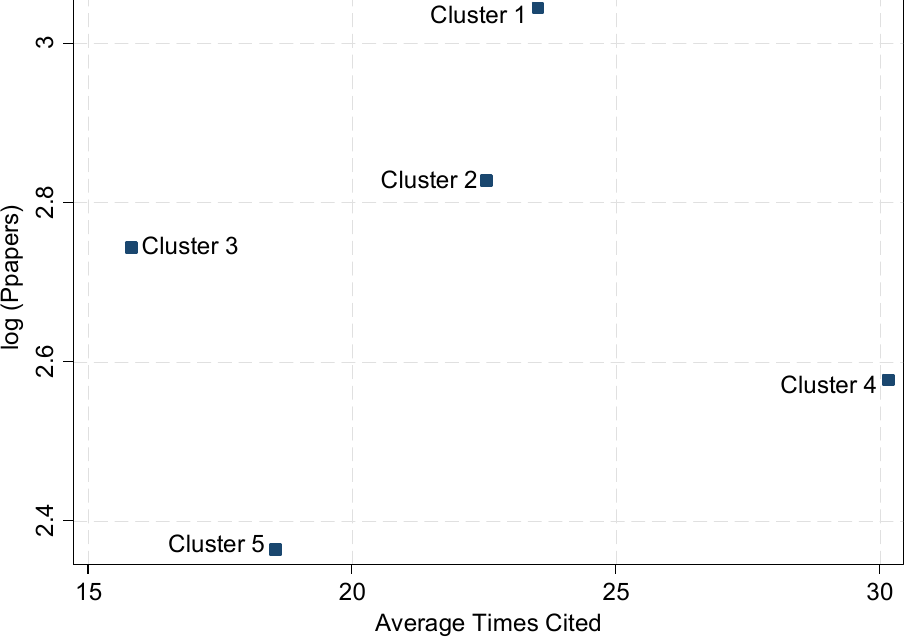
Figure 7. Analysis of streams of research on the most prominent clusters.